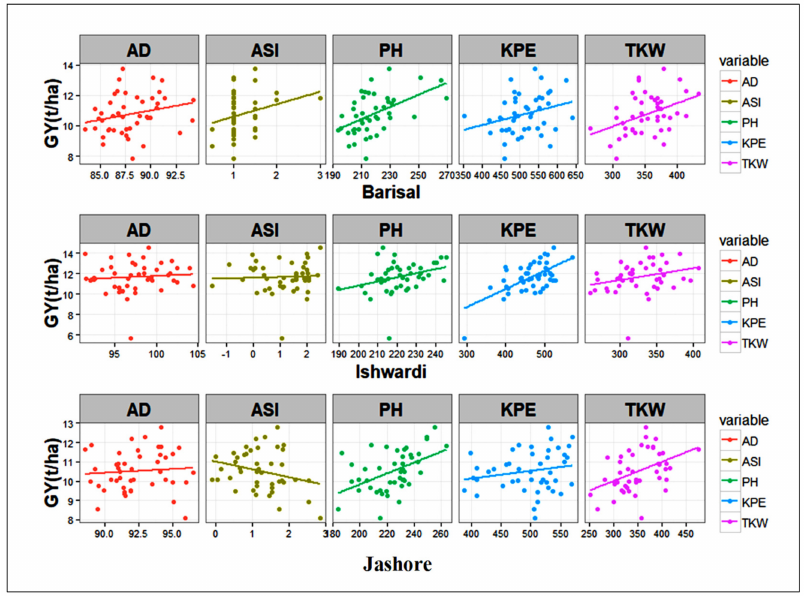
Figure 1. Graph displaying contributions of different traits to the grain yield